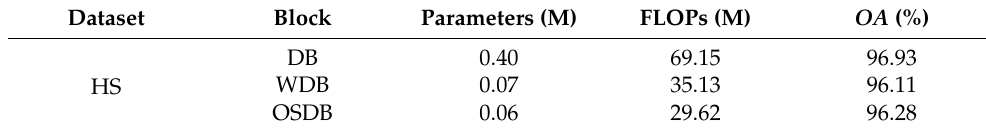
Table 20. The number of parameters, FLOPs, and OA of different dense blocks on the HS dataset. Dataset Block